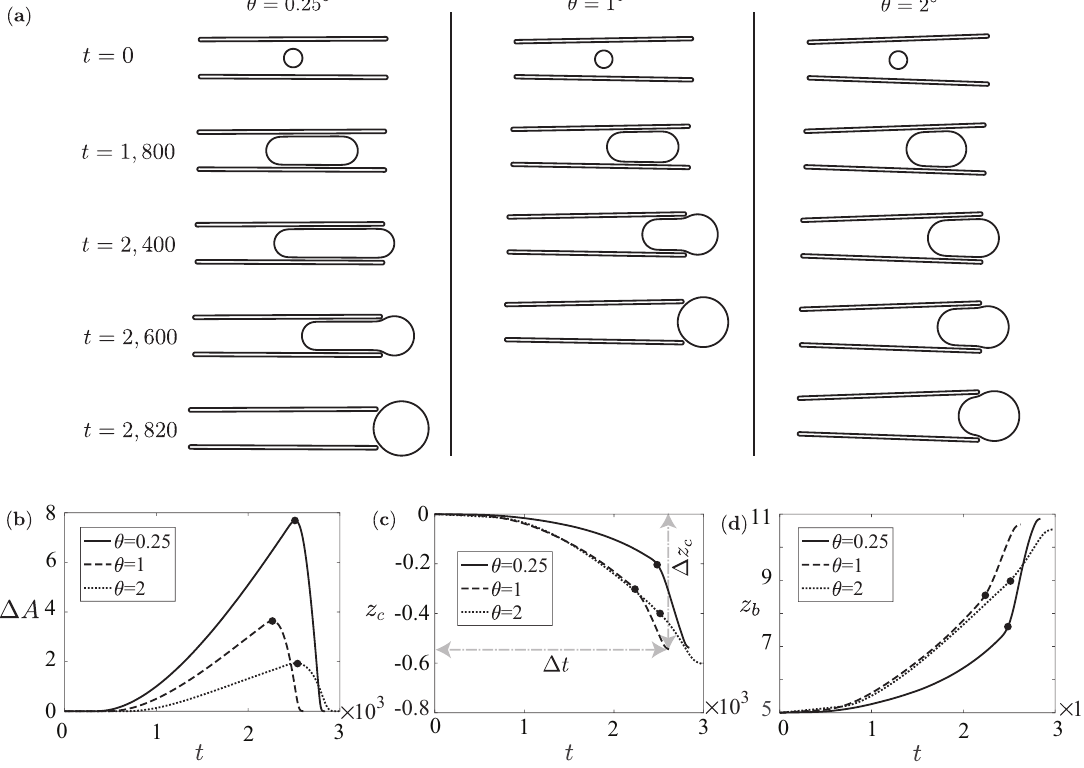
Figure 4. ( a ) Snapshots of the bubble-cone configuration for three opening angle θ = [ 0.25,1,2 ] ◦ , when Ca = 0.01, and corresponding time evolution of ( b ) excess surface area ∆ A ; ( c ) cone displacement z c and ( d ) bubble displacement z b . The dots indicate the times when the maximum excess surface area is